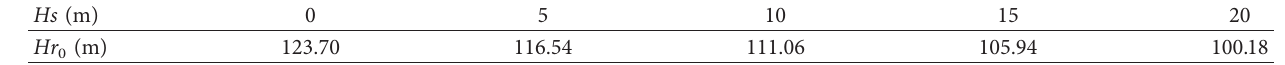
Table 7: Foundation pit Hr 0 in the binary strata of upper soil and lower rock.